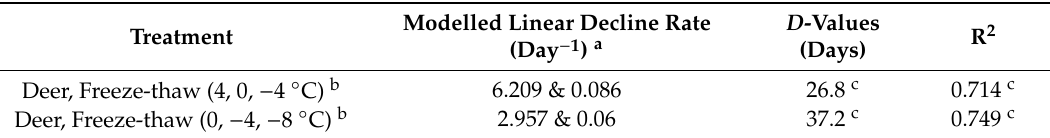
a = Linear decline rate constant = (2.303 × Figure 3 slope gradient) b = treatment split into a 2-stage linear decline (rapid and slow) c = values for “stage 2” slow